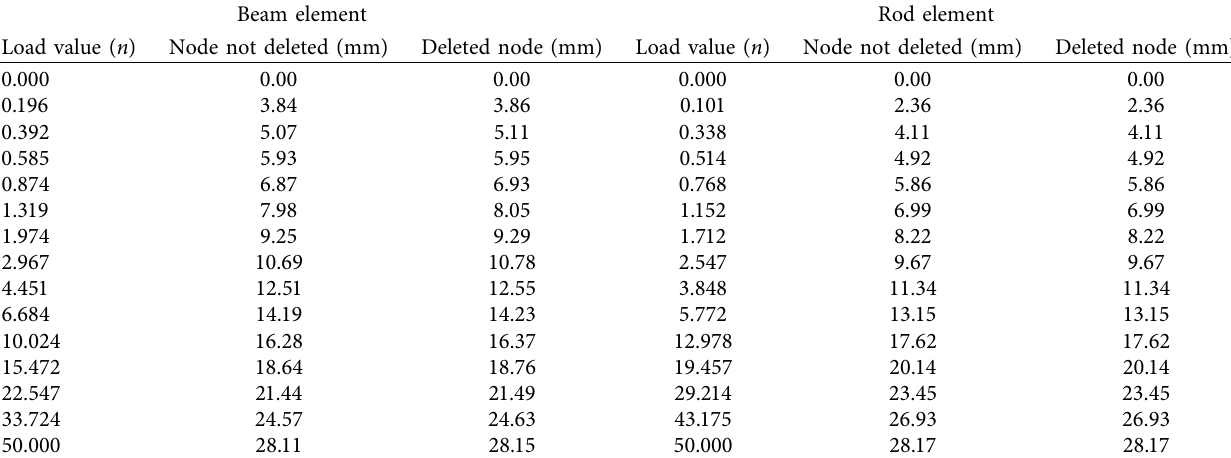
Table 6: Displacement values of beam element and bar element under different